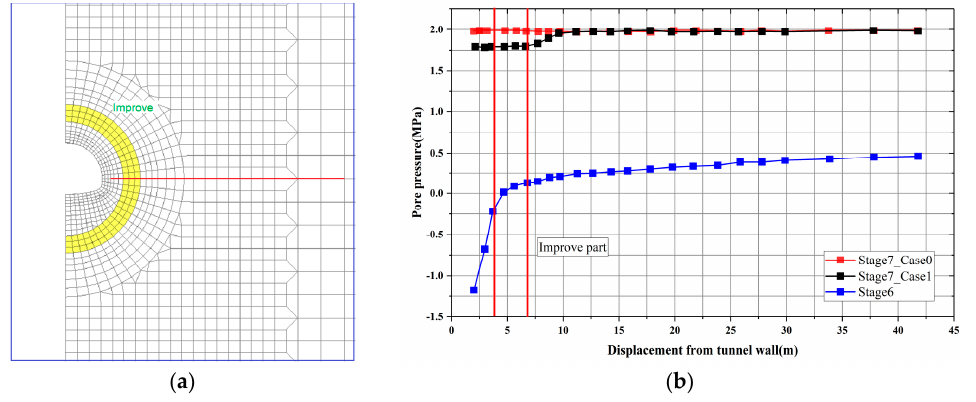
Figure 9. Comparison of pore pressure distributions along the horizontal direction. ( a ) Observed location; ( b ) simulation results.